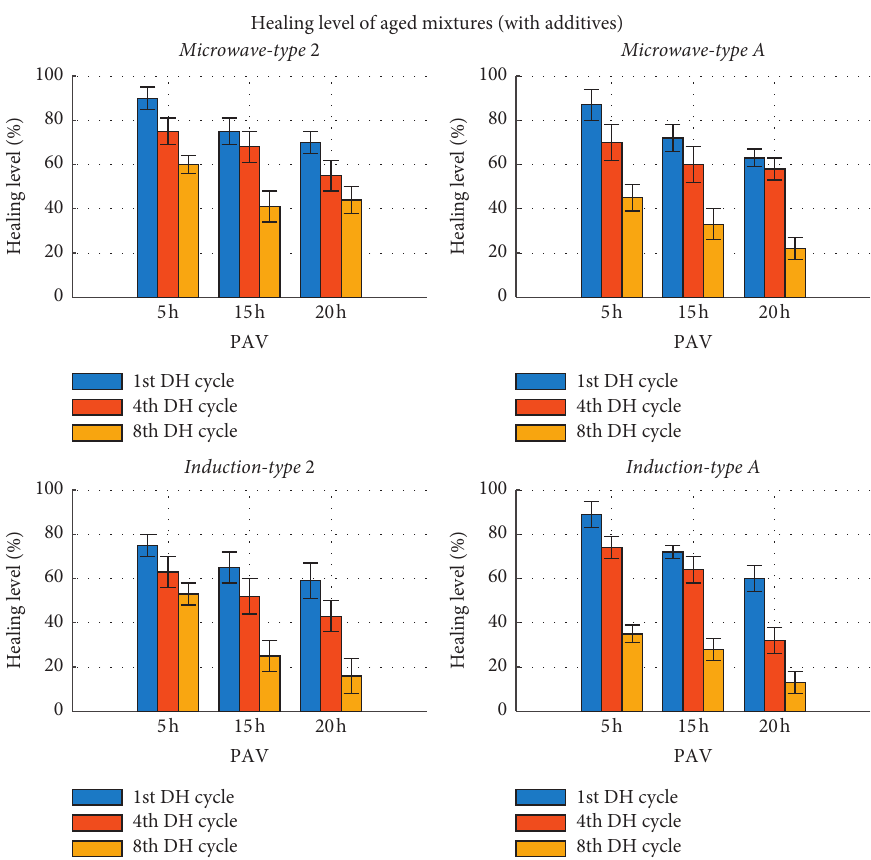
Figure 13: Healing level of aged mixtures modified with two additive agents. Table 6: Tukey’s HSD post hoc summary